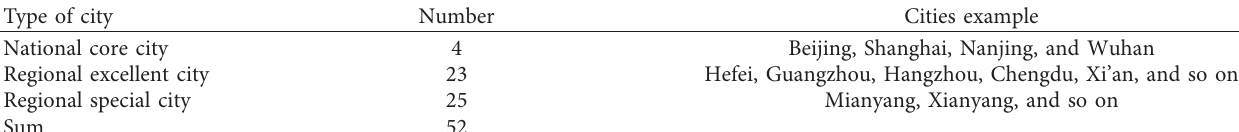
Table 4: City hierarchical structure in China.